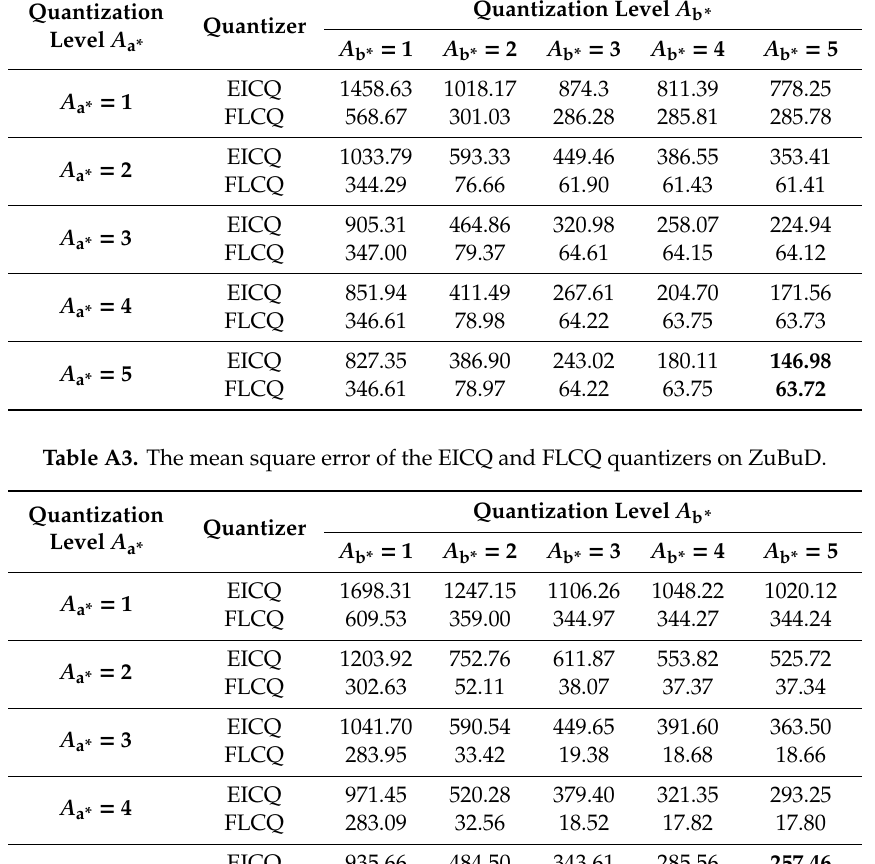
Table A2. The mean square error of the EICQ and FLCQ quantizers on ETHZ. Quantization